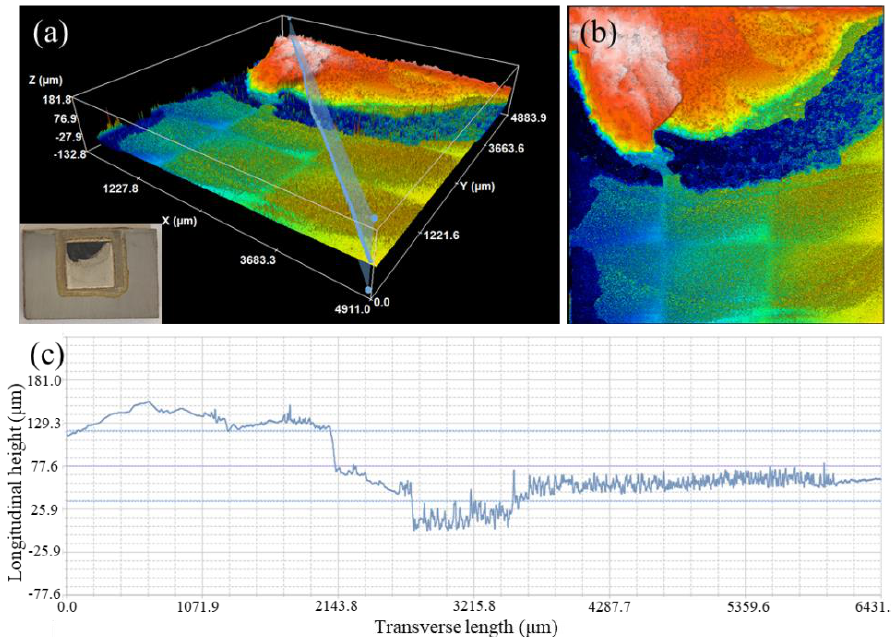
Figure 9. Fracture morphologies of brazed joints after introducing the MRLS. ( a ) three-dimensional view of the fracture morphology, ( b ) top-view of the fracture morphology, ( c ) height profile on the cross-section in figure ( a ).